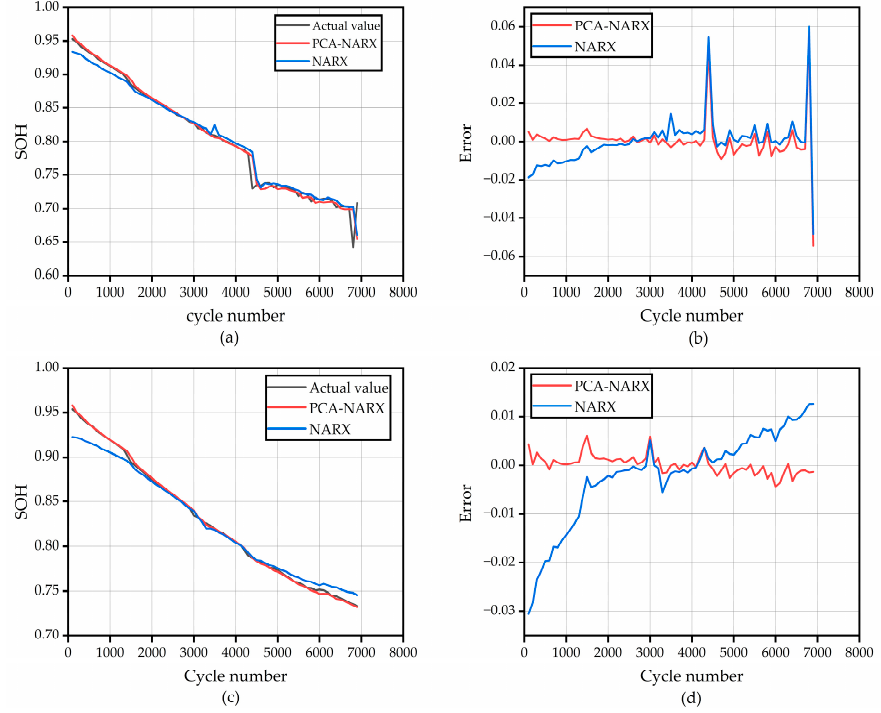
Figure 6. ( a ) SOH estimation curves of Cell 2 before and after PCA; ( b ) Errors of SOH estimation of Cell 2 before and after PCA; ( c ) Comparison of SOH estimation curves of Cell 3 before and after PCA; ( d ) Errors of SOH estimation of Cell 3 before and after